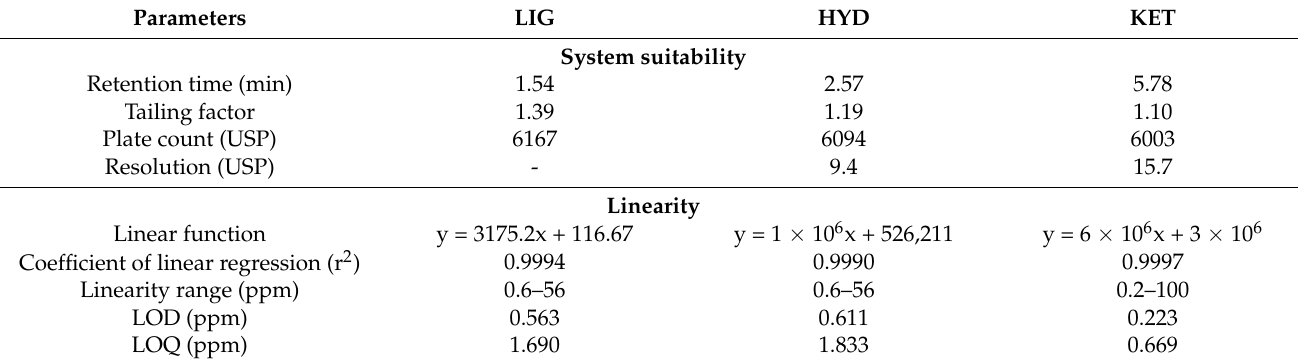
Table 1. System suitability and limit parameters of the proposed